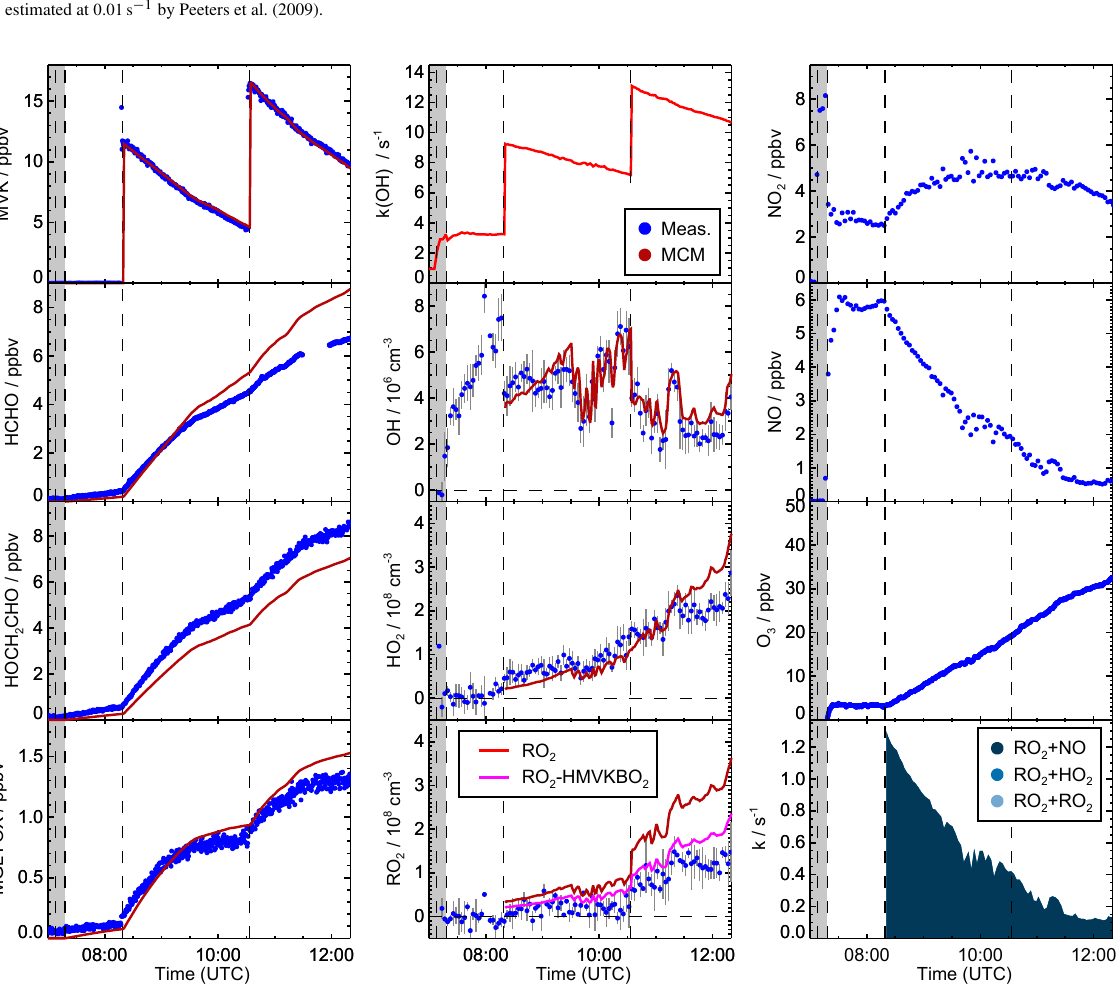
Figure 2. Time series of radicals, inorganic and organic species during the MVK photooxidation for the high NO experiment (20 Au- gust 2014) together with results from model calculations applying MCM. Dark shaded areas indicate the time before opening the chamber roof and vertical dashed line times when trace gases were injected into the chamber. OH reactivity was not measured during this experiment. NO, NO 2 and O 3 are constrained to measurements in the model. RO 2 loss rates (most lowest right panel) are calculated from modelled HO 2 , RO 2 and NO concentrations. However, contributions from the reactions with RO 2 and HO 2 or RO 2 are too small to be visible. Modelled acetic acid concentrations are small compared to modelled glycolaldehyde concentrations (measured together in the